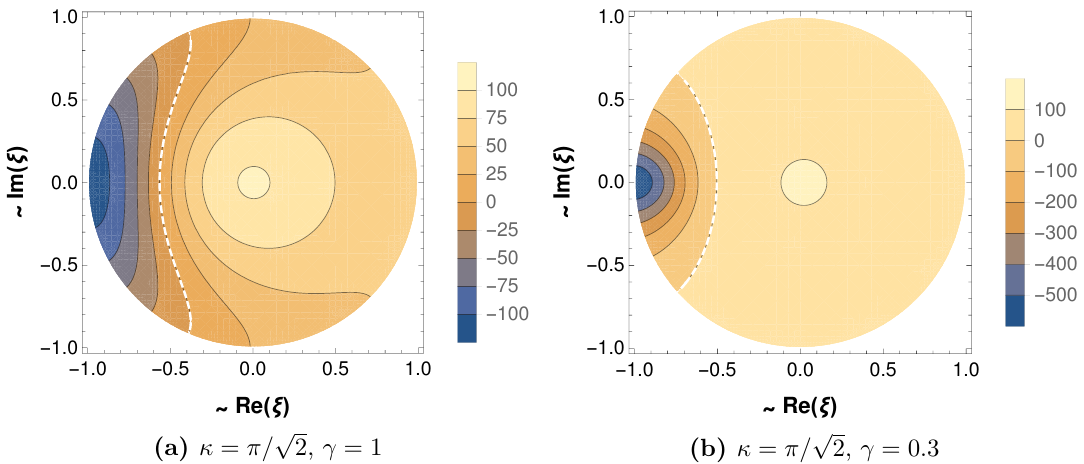
Figure 3. Contour plots of ~ g yy with ( a = 1 ; R y = 1 ; (cid:18) = 0 ; c = 100) for speci(cid:12)ed F ( (cid:24) ). Plotted on the unit disc j (cid:24) j (cid:20) 1 with radial direction rescaled to tan r . The boundaries between positive and negative domains (~ g yy = 0) are separated by a dashed white line.